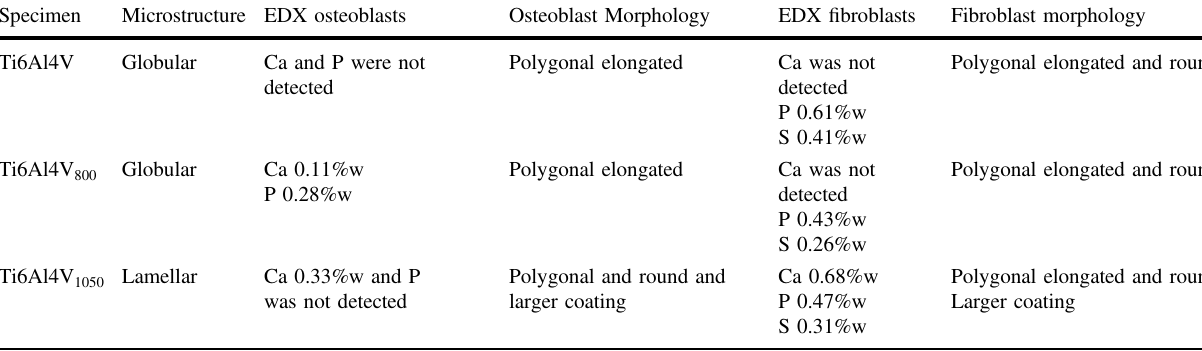
Table 2 Summary results [26,